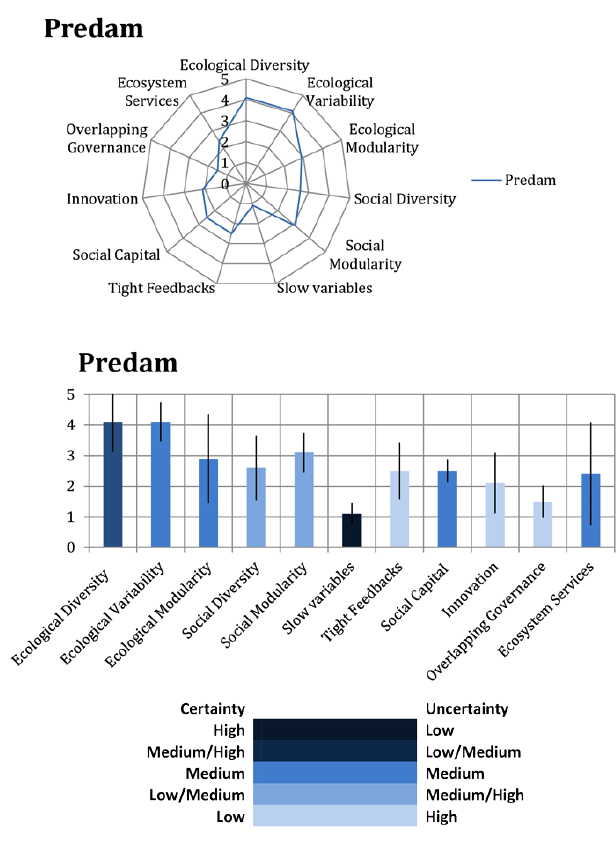
Fig. 2 . Resilience of the central Platte River social-ecological system in regard to Walker and Salt’s (2006) nine resilience properties and level of uncertainty associated with each property during the time period before the Kingsley